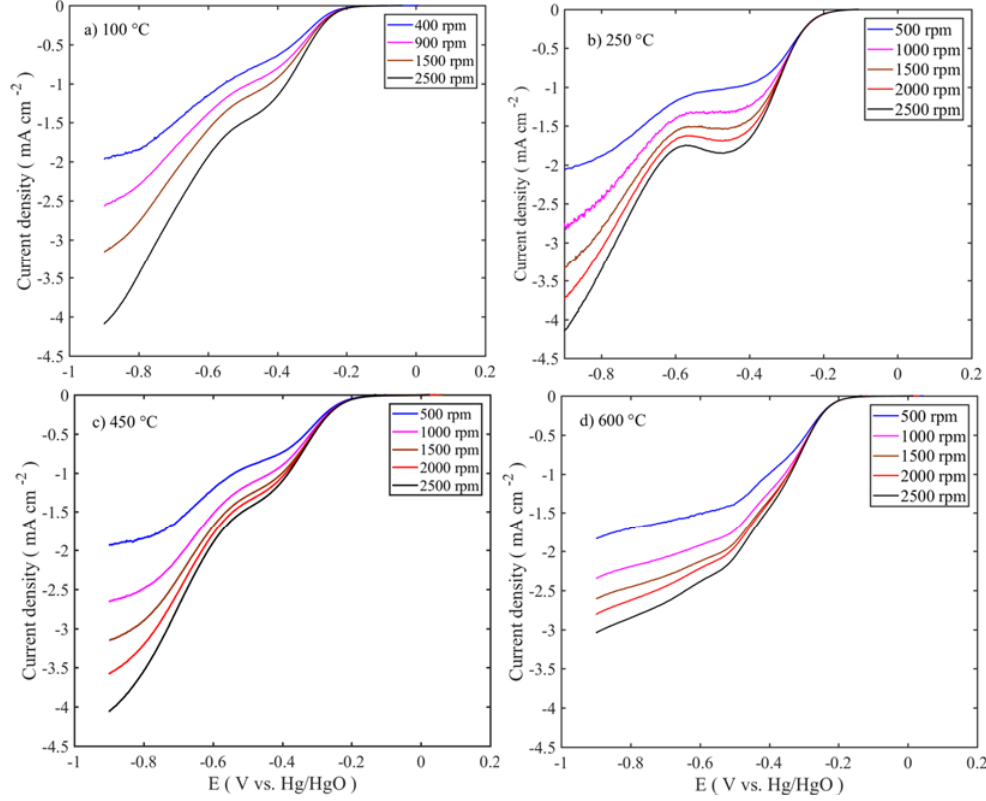
Figure 8. RDE curves of 0.75 mg cm − 2 NiFe samples calcined at different temperatures in 0.1 M KOH with 5 mV s − 1 at different rotation rates (400–2500 rpm) ( a ) 100; ( b ) 250 °C ; ( c ) 450 °C , and ( d ) 600 °C .